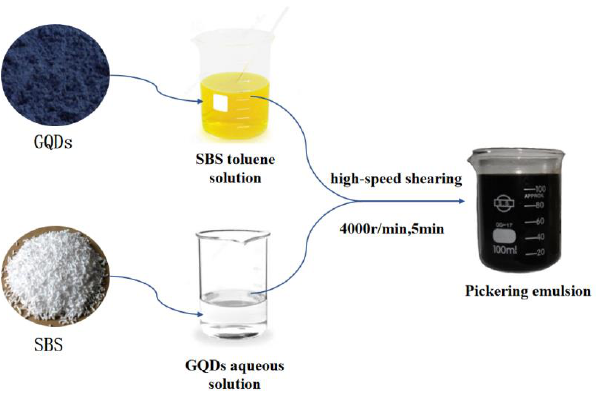
Figure 1. The preparation process of GQDs/SBS composite modifier Pickering emulsion.